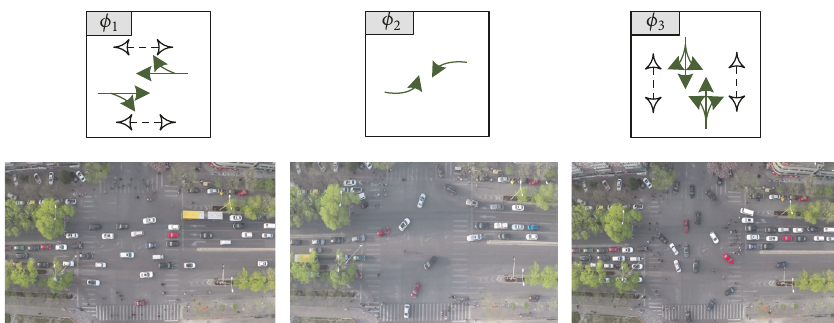
Figure 6: Signal phasing at study site.